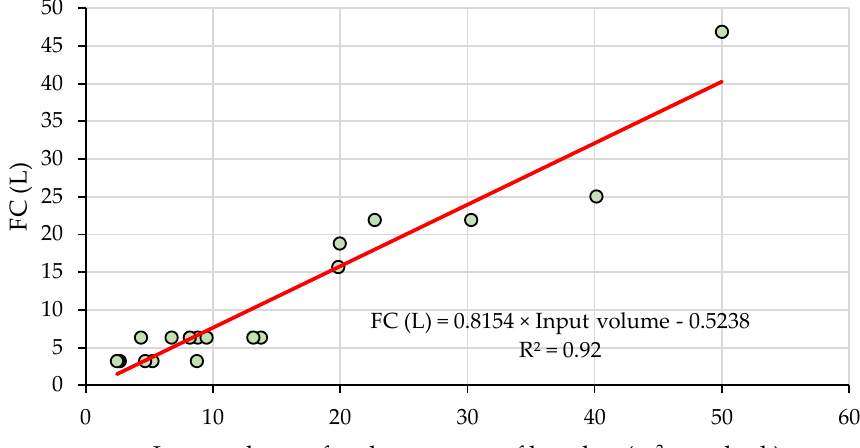
Figure A3. Dependence relationship between the fuel consumption and the input volume of bunches or groups of bunches. Note: some bunches had common onboard readings. Normality and heteroskedasticity assumptions were not met.